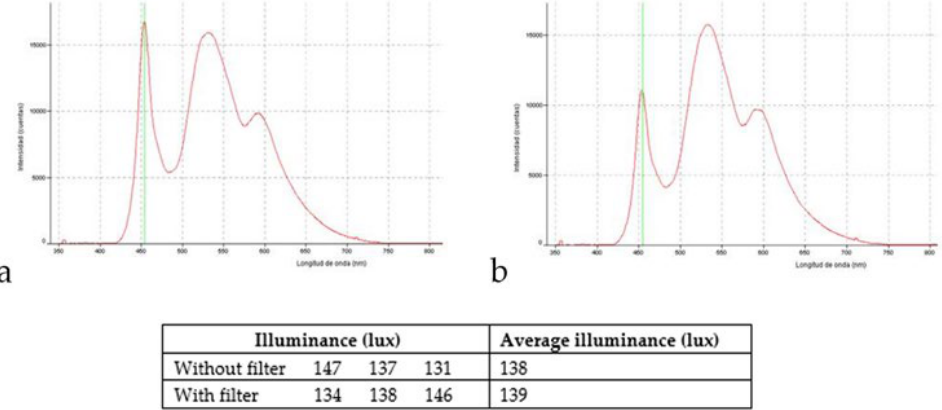
Figure 1. Characteristic of the light LED screen emission and the illuminance (lux) measured inside the study cages; ( a ) without optical filter; ( b ) with the optical